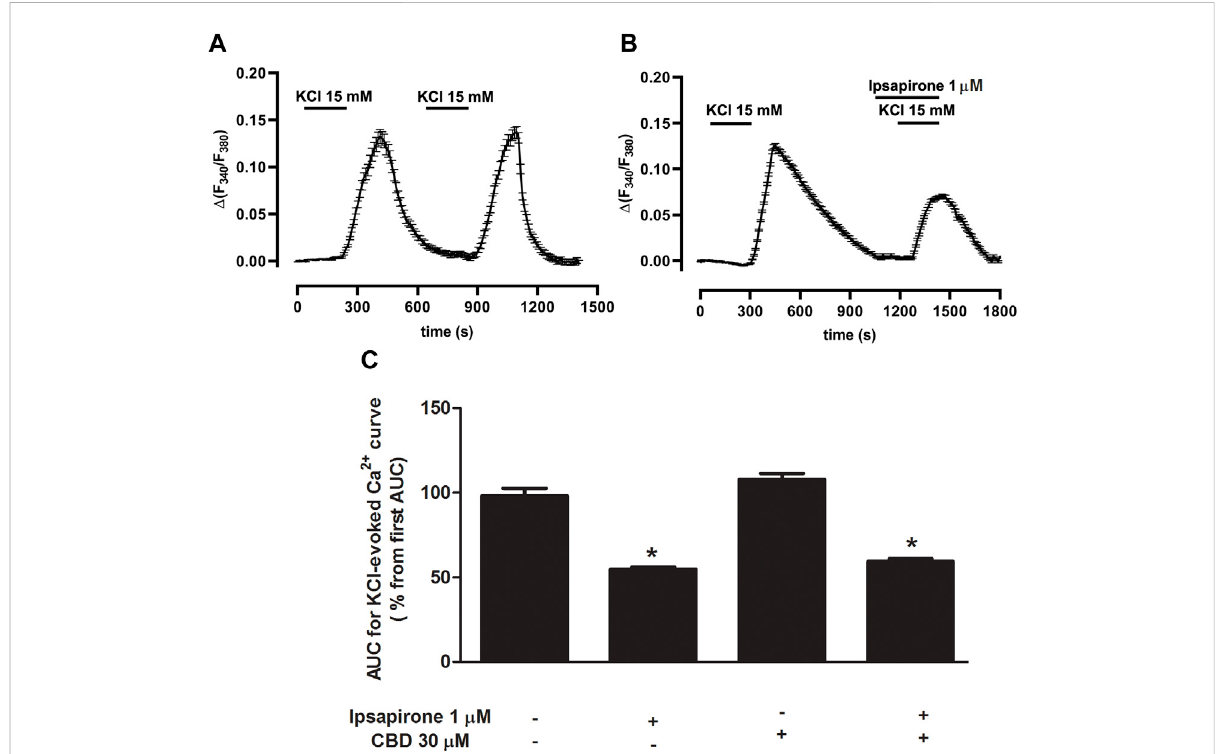
FIGURE 4 Effect of ipsapirone and CBD on KCl-evoked calcium in fl ux in DRN. (A,B) Representative recordings of KCl-evoked (15 mM, 4 min) [Ca 2+ ]i in DRN 5-HT cells in the absence (A) or presence of ipsapirone (1 µM) (B) . Vertical lines refer to the change in KCl-evoked 340/380 ratio, and the horizontallinesrepresentthetimescale. (C) Barhistogramsshowingmean±SEMoftheAUCforKCl(15 mM)-evoked[Ca 2+ ]iinDRN5-HTcellsinthe absence ( n = 29 cells, three slices from three rats)and presence of ipsapirone (1 µM)( n = 26 cells, three slices from three rats), CBD (30 μ M, n = 21 cells, three slices from three rats), and CBD (30 µM) + ipsapirone (1 µM) ( n = 17 cells, three slices from two rats). Each histogram represents the mean ± SEM of the percentage from the fi rst AUC for KCl-evoked [Ca 2+ ]i. * p < 0.001 compared with the corresponding groups without ipsapirone (1 µM) by two-way ANOVA (with CBD and ipsapirone as the main factors) followed by Bonferroni´s post-hoc